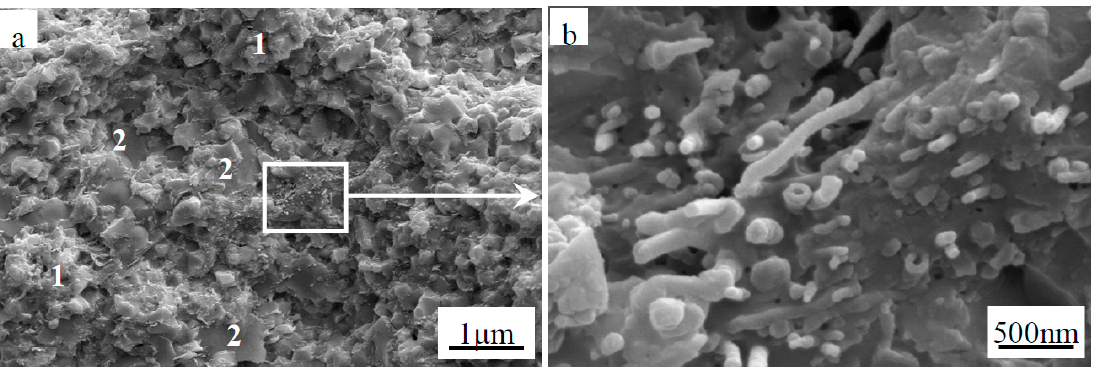
Figure 4. Secondary electron SEM images of fracture surface of ( a ) ZrB 2(nano) -5 wt % CNTs composites (“1” represents intergranular fracture, “2” represents transgranular fracture); and ( b ) magnified region.